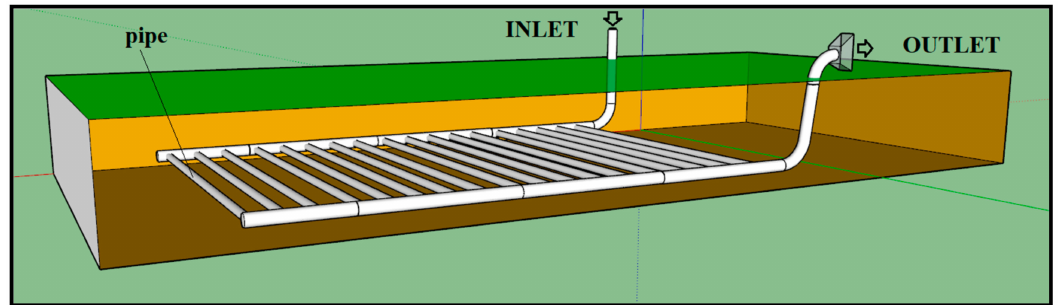
Figure 3. The layout of the horizontal air-ground heat exchangers.